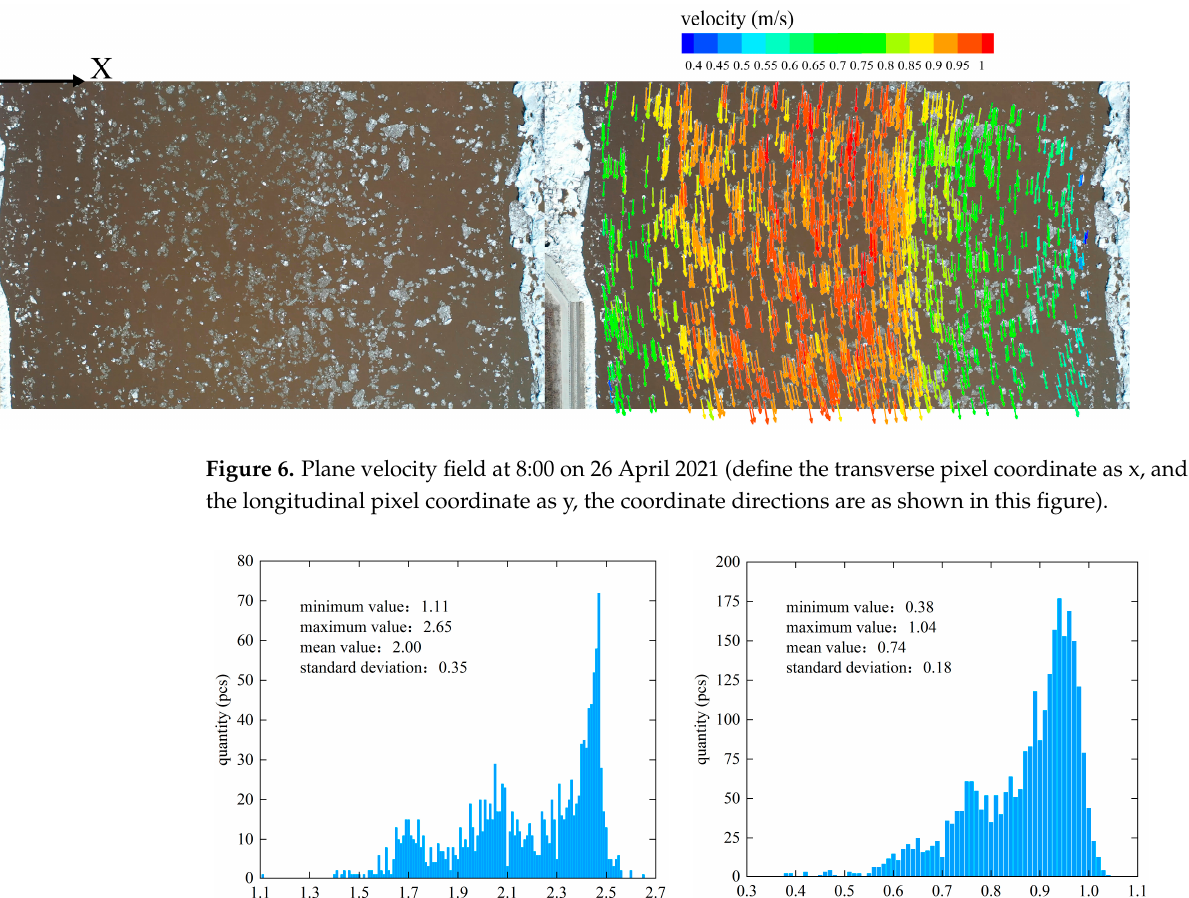
Figure 5. Plane velocity field at 16:00 on 25 April 2021 (define the transverse pixel coordinate as x, and the longitudinal pixel coordinate as y, the coordinate directions are as shown in this figure).